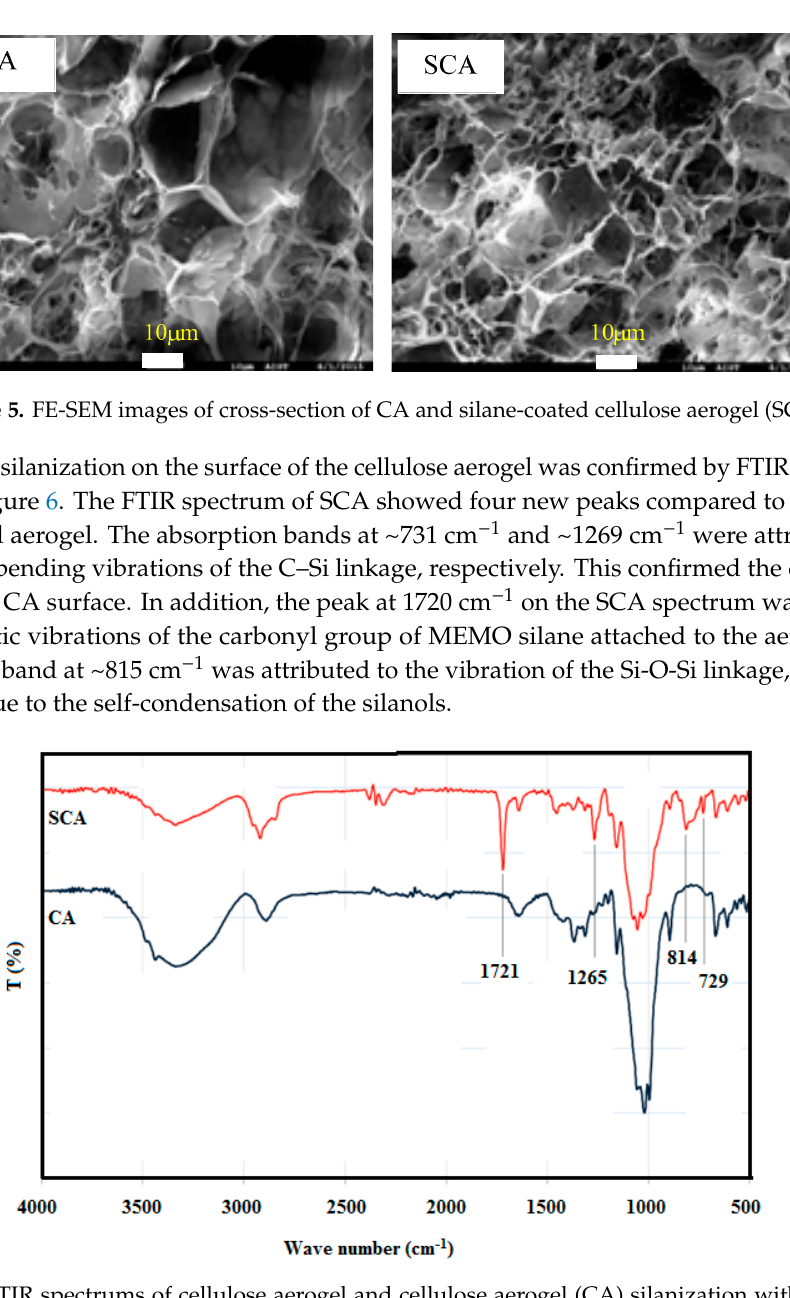
Figure 6. FTIR spectrums of cellulose aerogel and cellulose aerogel (CA) silanization with MEMO silane